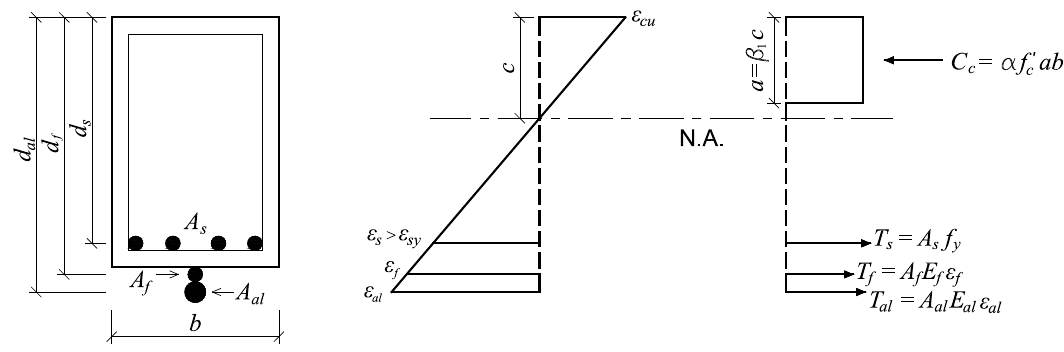
Figure 11. Strain and stress distribution at critical